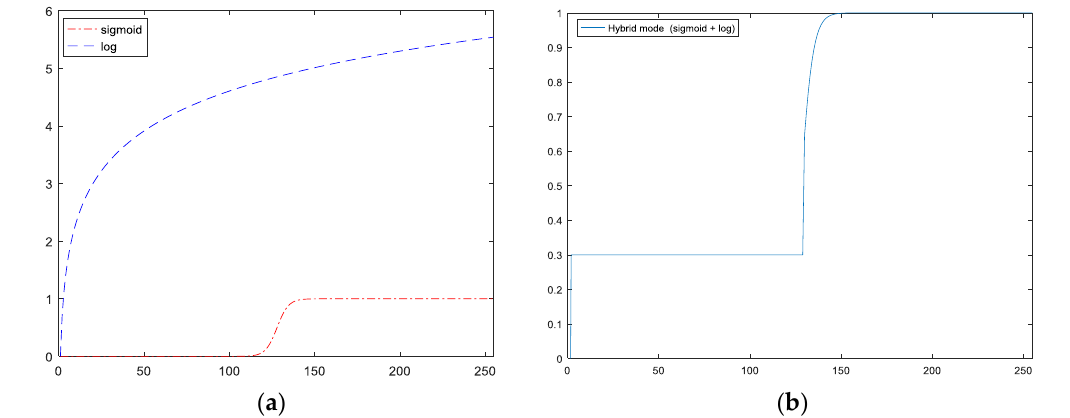
Figure 9. ( a ) Sigmoid function vs. standard Log function ( b ) our Sigmoid function.